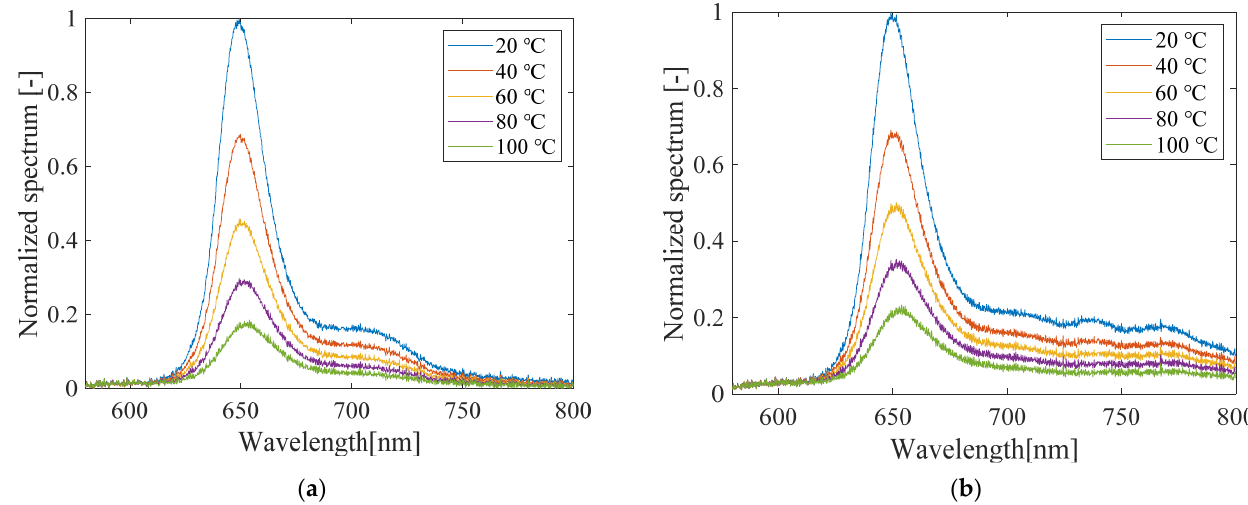
Figure 17. Luminescence spectra of PC-PSP with 1.0 g of urethane resin ( a ) after the heat treatment and ( b ) after photodegradation.